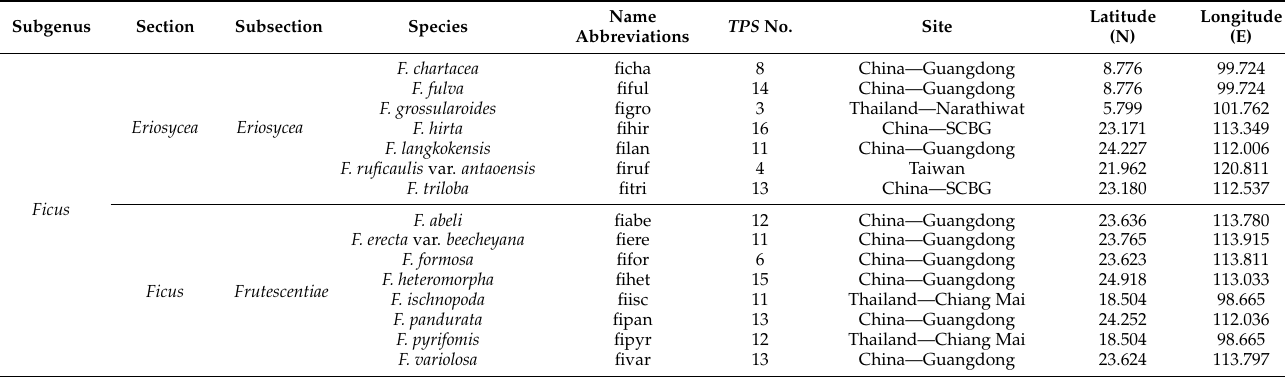
Table 1. Twenty-four Ficus species used in this